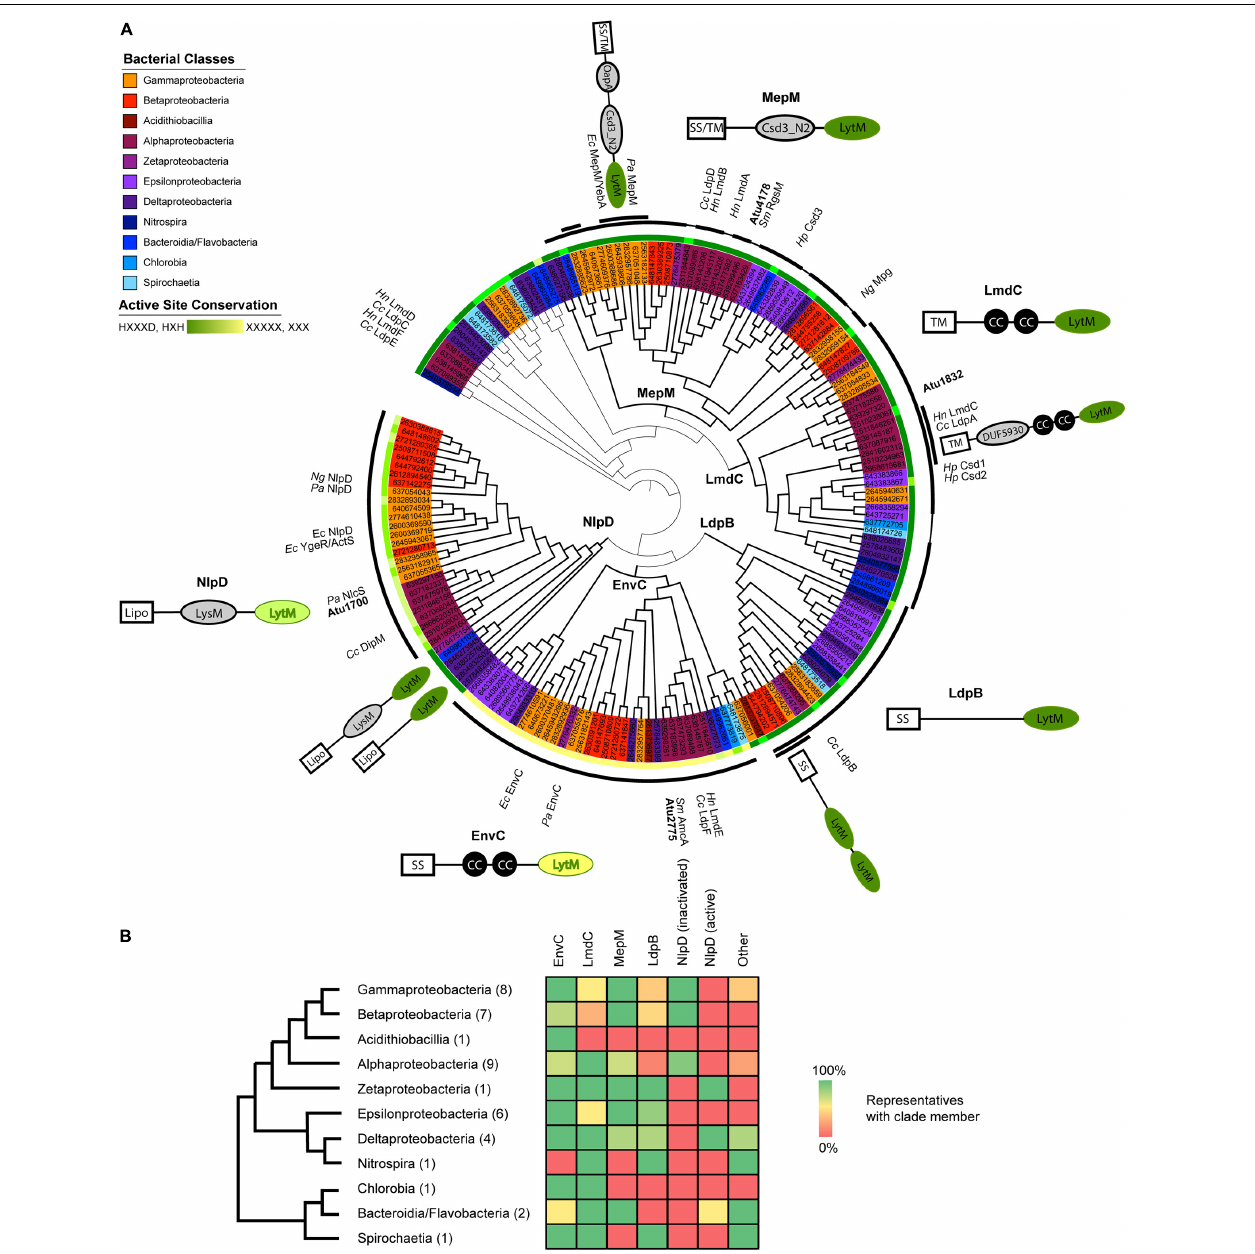
FIGURE 1 | Proteobacterial LytM domain-containing proteins segregate phylogenetically into five major classes with identifiable features outside of the LytM domain. (A) Maximum likelihood gene tree of LytM factors constructed with aligned LytM domains from 41 representative species from the Proteobacteria and deep-branching Proteobacteria. The five clades are labeled at their branch point and emphasized by thicker branch weights. This tree has been arbitrarily rooted to clarify the structure of the five clades (see also Supplementary Figure 1 ). The taxa are colored according to bacterial class (see legend) and shown as JGI ID numbers, which are associated with genetic loci and genomes in Supplementary Table 1 . Taxa that have been studied and named are labeled in the outermost ring ( Cc , Caulobacter crescentus ; Ec , Escherichia coli ; Hn , Hyphomonas neptunium ; Hp , Helicobacter pylori ; Ng , Neisseria gonorrhoeae ; Pa , Pseudomonas aeruginosa ; Sm , Sinorhizobium meliloti ). The first ring outside of the taxa indicates the degree to which the active site motif (HXXXD, HXH) is conserved, with dark green indicating full conservation and yellow indicating loss of all conservation. See also Supplementary Figure 3 for LytM consensus sequences for each clade. The thick black arcs identify which members of the clade include the schematized N-terminal domains and help distinguish where clades begin and end. Some MepM and LmdC members did not have clade-associated domains, which is indicated by a thinner connecting line within the arc. Some groups of LytM factors shared additional features and these are indicated by a second arc layer. Schematics of characteristic clade architectures appear horizontally next to the clades. LytM domains are colored according to active site conservation. N-terminal domains are colored in gray: LysM, PG-binding domain; CC, coiled-coil motif; DUF5930; Csd3_N2, autoinhibition domain identified in Csd3 of H. pylori ; OapA, PG-binding domain identified in OapA of H. influenzae . Subclade architectures appear at an angle close to the arc of the sequences they represent. Some genes have more copies than the indicated number of N-terminal domains; for signal sequences